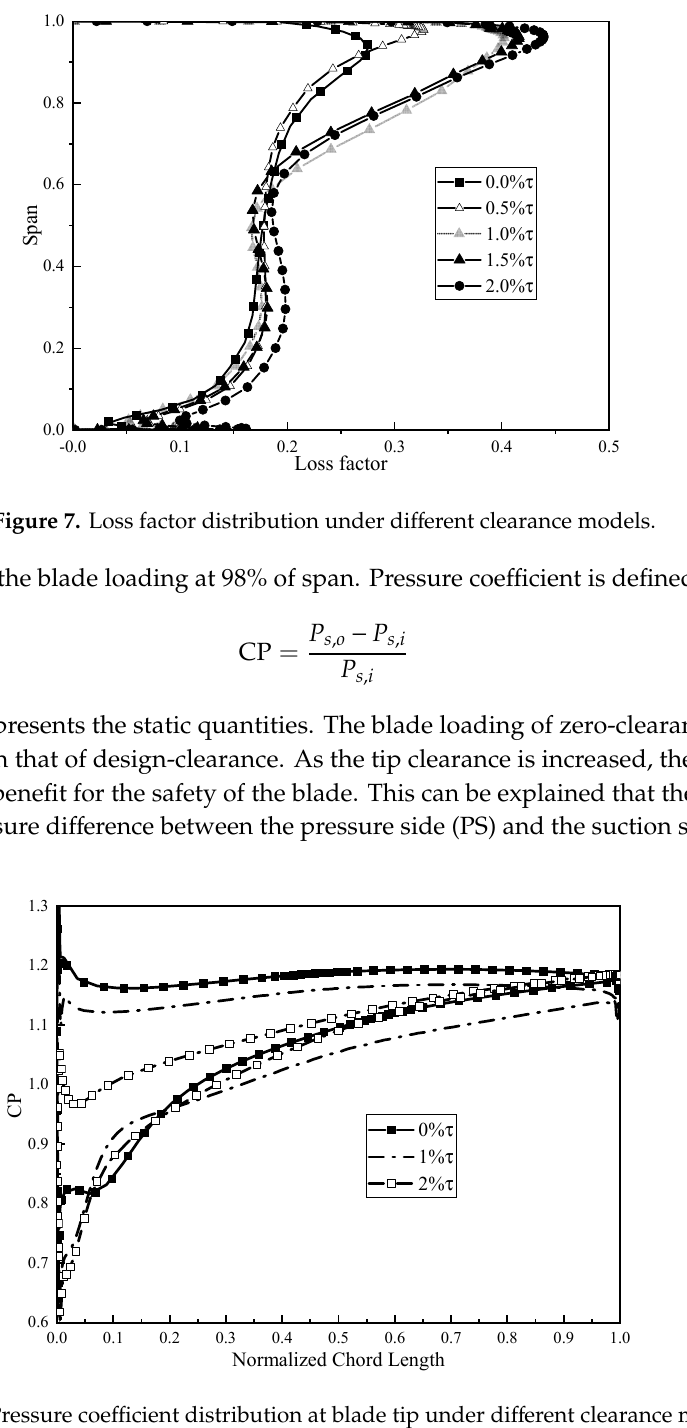
Figure 8. Pressure coefficient distribution at blade tip under different clearance models.